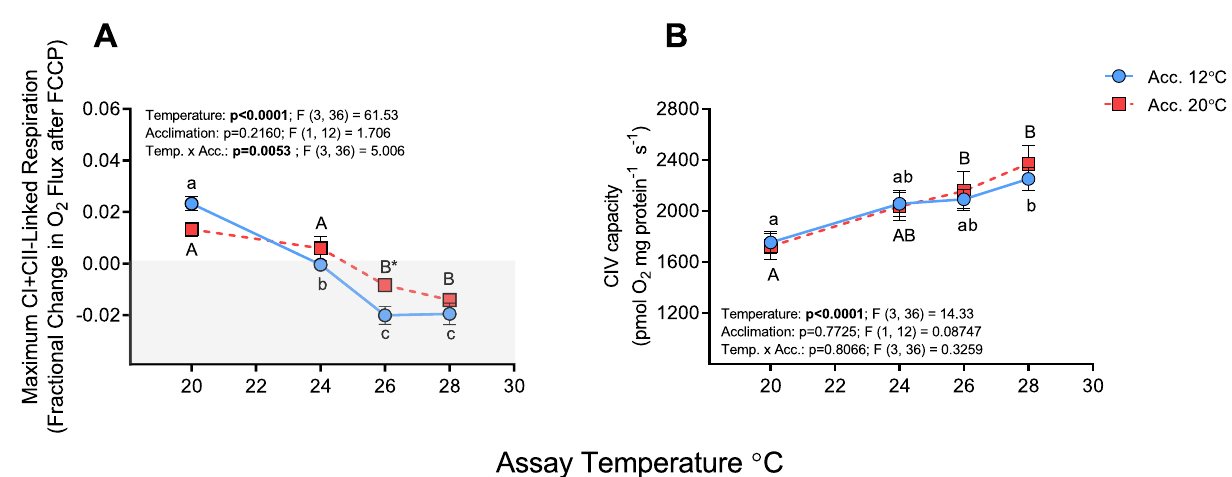
Figure 5. Maximum substrate oxidation capacity (ETS-I + II) and complex IV (CIV) capacity in cardiac mitochondria from cold- (12 °C) and warm- (20 °C) acclimated salmon when measured at 20, 24, 26 and 28 °C. Maximum capacity of ( A ) CI + CII-linked respiration (ETS-I + II) expressed as fractional change in O 2 flux following addition of the uncoupler FCCP (0.25 µmol L −1 ); and of ( B ) complex IV (CIV) following the addition of the CIV electron donor TMPD (5 mmol L −1 ) + ascorbate (10 mmol L −1 ), then sodium azide (8 mmol L −1 , an inhibitor of CIV used to correct for TMPD autoxidation). An asterisk (*) indicates a significant (P < 0.05) difference between acclimation groups within an assay temperature, whereas letters (a, A) indicate a significant difference between assay temperatures within an acclimation group. In panel A, the gray area indicates values less than zero (i.e., that FCCP had an inhibitory effect). Values are means ± s.e.m., N = 7 per